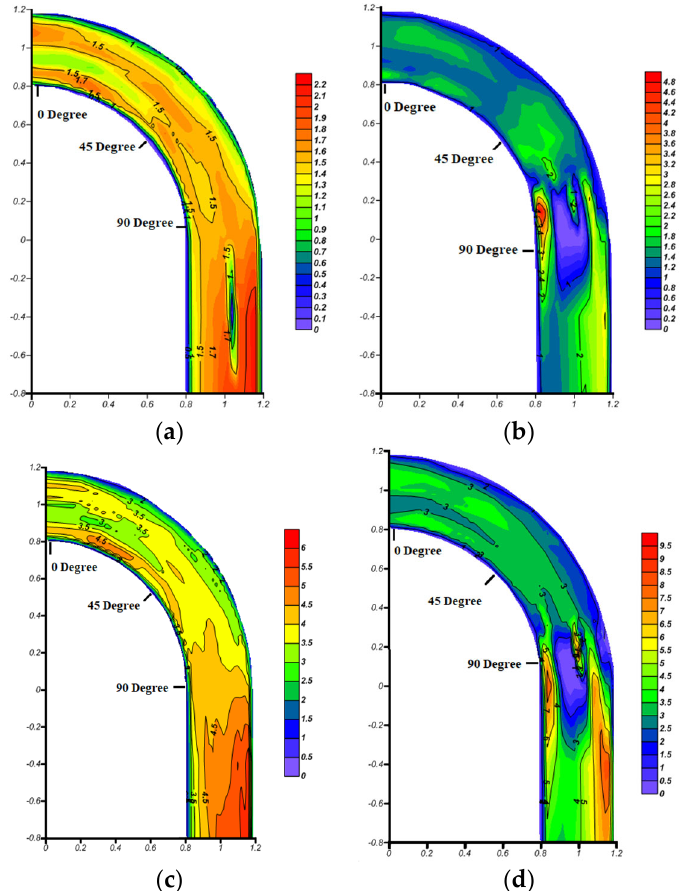
Figure 12. Distribution of shear stress of the bed with both states with and without a weir. ( a ) With W − Weir and 0.17 Froude number. ( b ) Without W − Weir and 0.17 Froude number. ( c ) With W − Weir and 0.28 Froude number. ( d ) Without W − Weir and 0.28 Froude number.